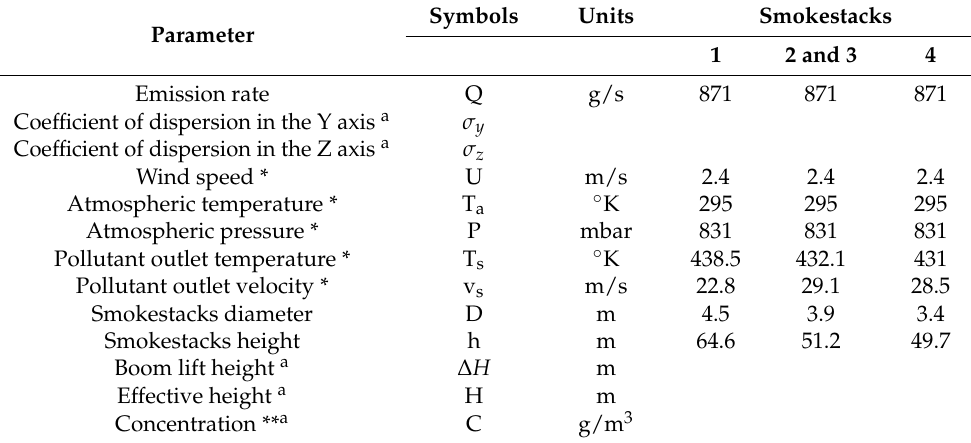
Table 8. Stack data, emissions, and geographic and meteorological conditions. Symbols Parameter